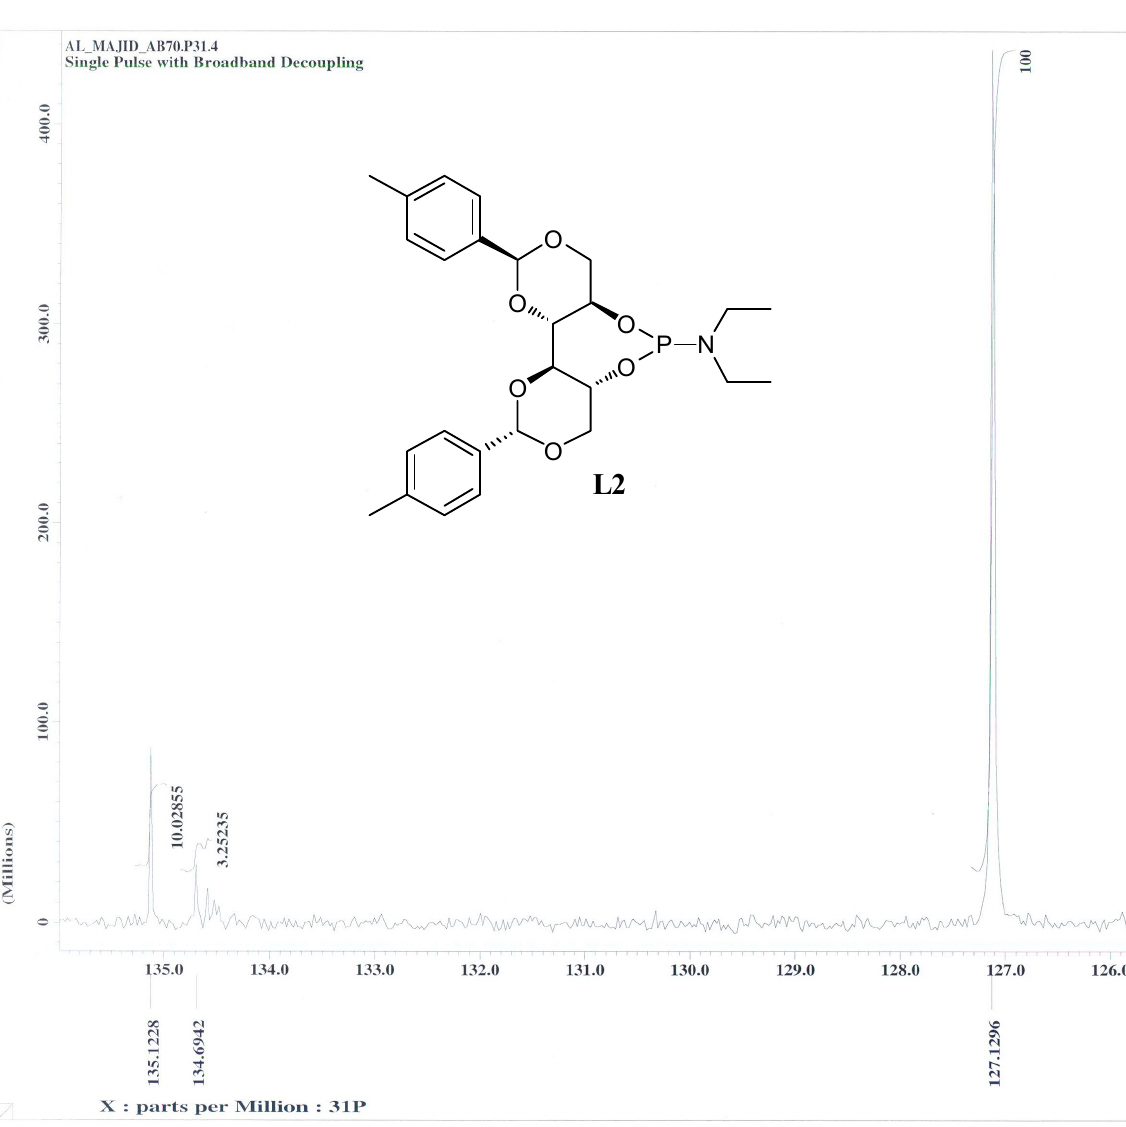
Figure 2. 31 P NMR data of the mixture isomers of L2